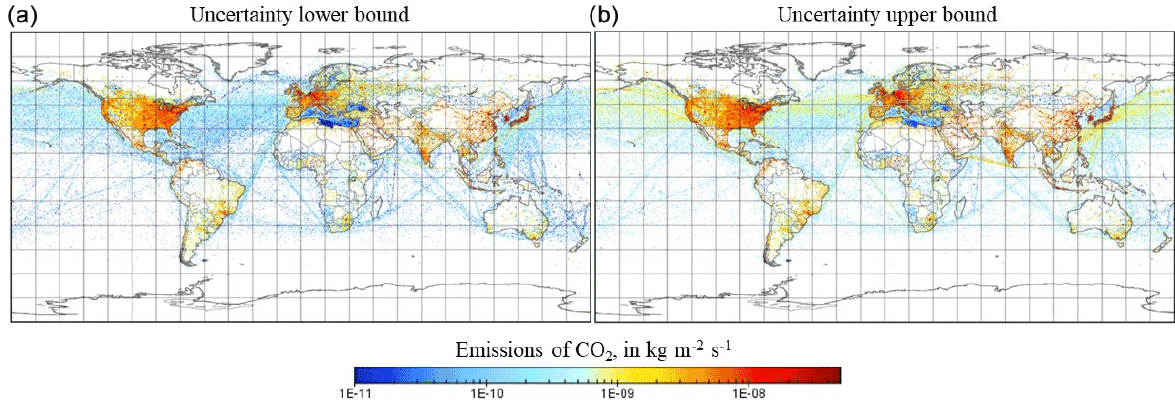
Figure 3. CO 2 emission flux uncertainties ( a lower- and b upper-half ranges of uncertainty) for the TRANSPORT group in kgm − 2 s − 1 . Table 5. Comparison of global anthropogenic CO 2 emission uncertainty at 2 σ associated with certain emission